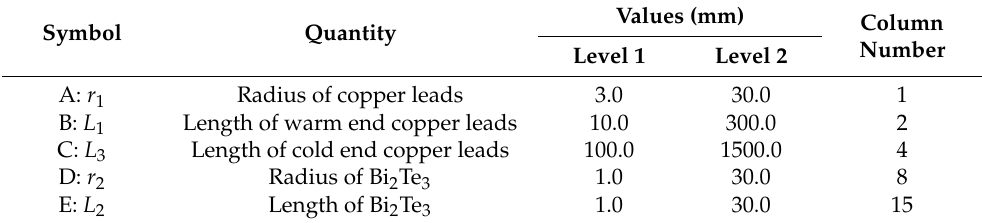
Table 1. Orthogonal experimental design for 120 A